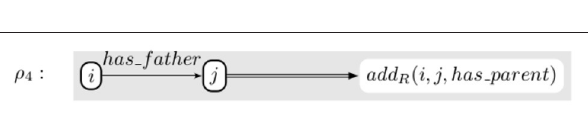
FIGURE 7 | Examples of rules rewriting transformations when deleting the label of node.